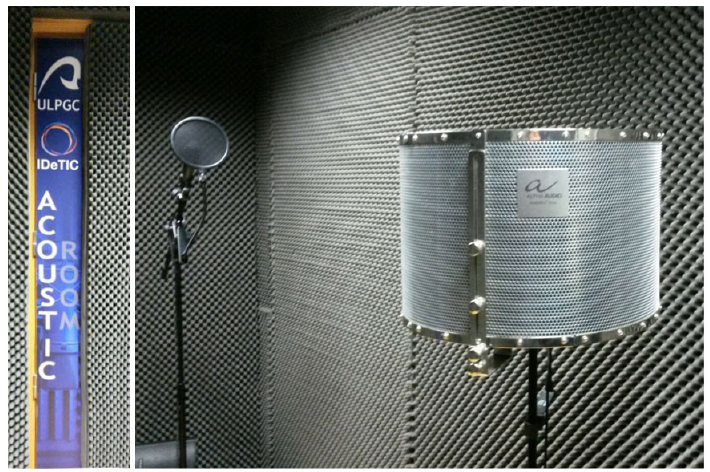
Figure 6. Acoustic anechoic chamber at